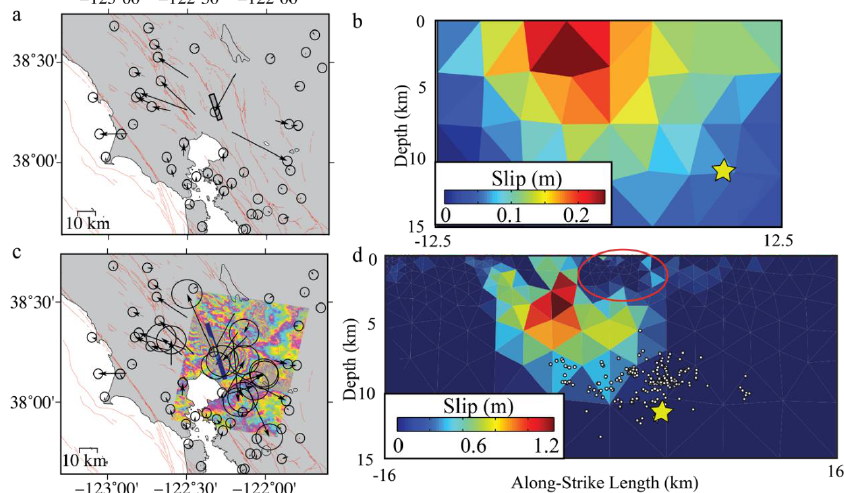
Figure 7. Examples highlighting the evolution of geodetic source models of the 2014 South Napa, California earthquake. ( a ) Co-seismic GPS displacements derived from continuous GPS time series one <24 hours following the earthquake. The gray box indicates the location of the derived fault model. ( b ) Co-seismic slip distribution derived from the co-seismic displacements in panel a. The star indicates the hypocenter of the earthquake. ( c ) Co-seismic GPS displacements derived from both continuous and campaign GPS measurements and a co-seismic COSMO-SkyMed interferogram. The co-seismic slip distribution is shown in map view. ( d ) Co-seismic slip distribution derived from the observations in panel c. The star indicates the hypocenter of the earthquake, and white dots are the locations of early aftershocks. The red circle indicates the region of later surface afterslip. Observations and slip distributions adopted from [7].